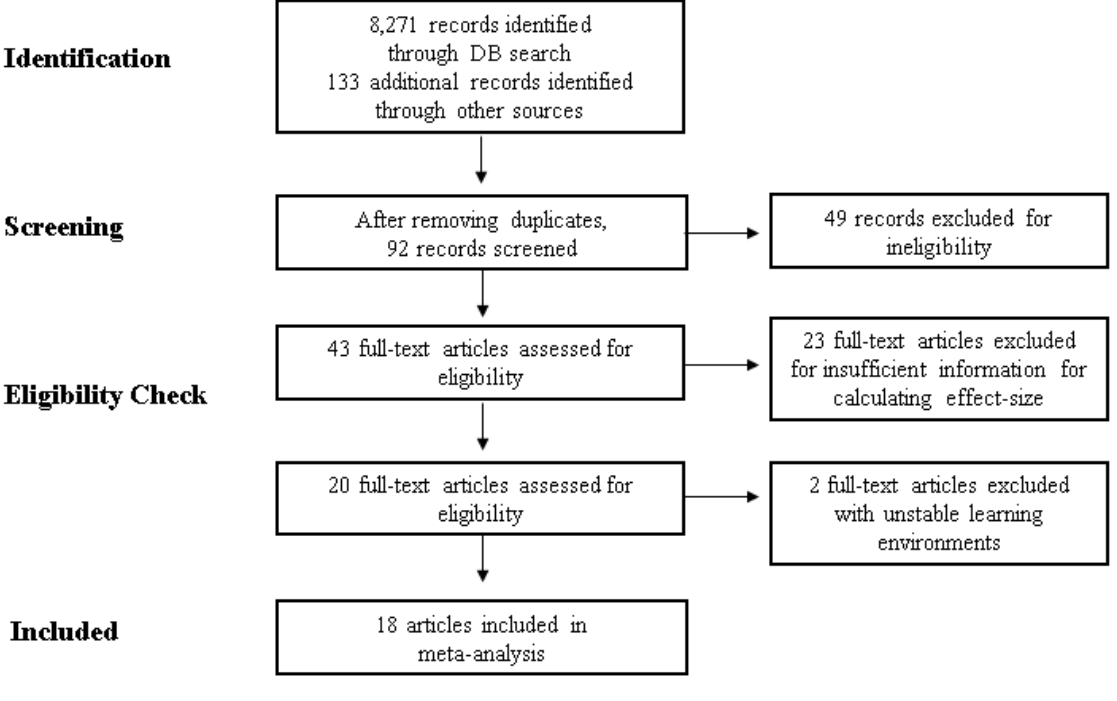
Figure 1. Search and exclusion